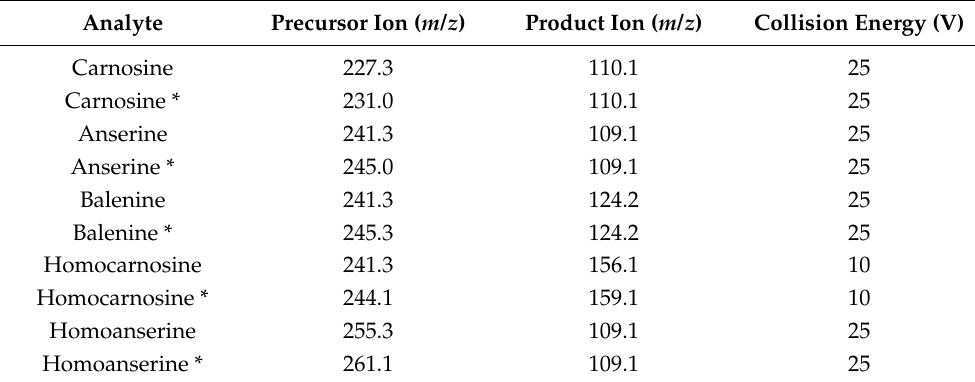
Collision energies were optimized to produce the highest signal intensities of product ions. Asterisks indicate isotope-labeled